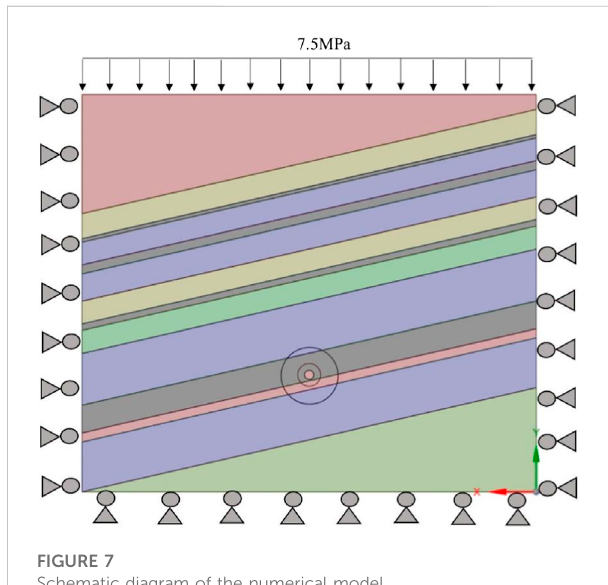
Table 3. To record the dynamic stress of the modi fi ed roadway in the numerical simulation, the monitoring points were arranged at different positions around the modi fi ed roadway. The detailed layout and numbering of monitoring points are shown in Figure 8.